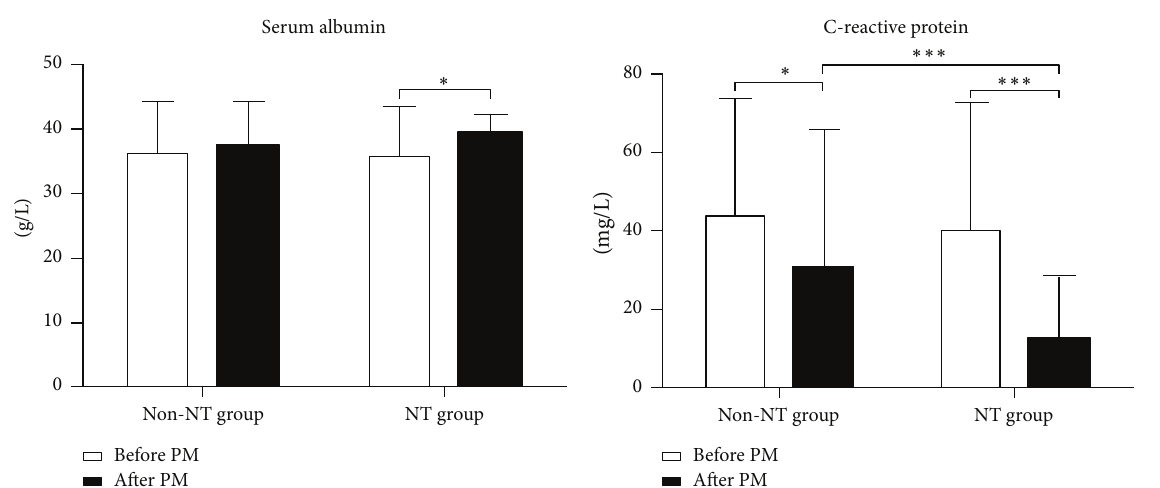
Figure 1: Serum albumin and C-reactive protein levels before and after preoperative managements. PM, preoperative managements; ∗ 𝑃 < 0.05 ; ∗∗∗ 𝑃 < 0.001 .